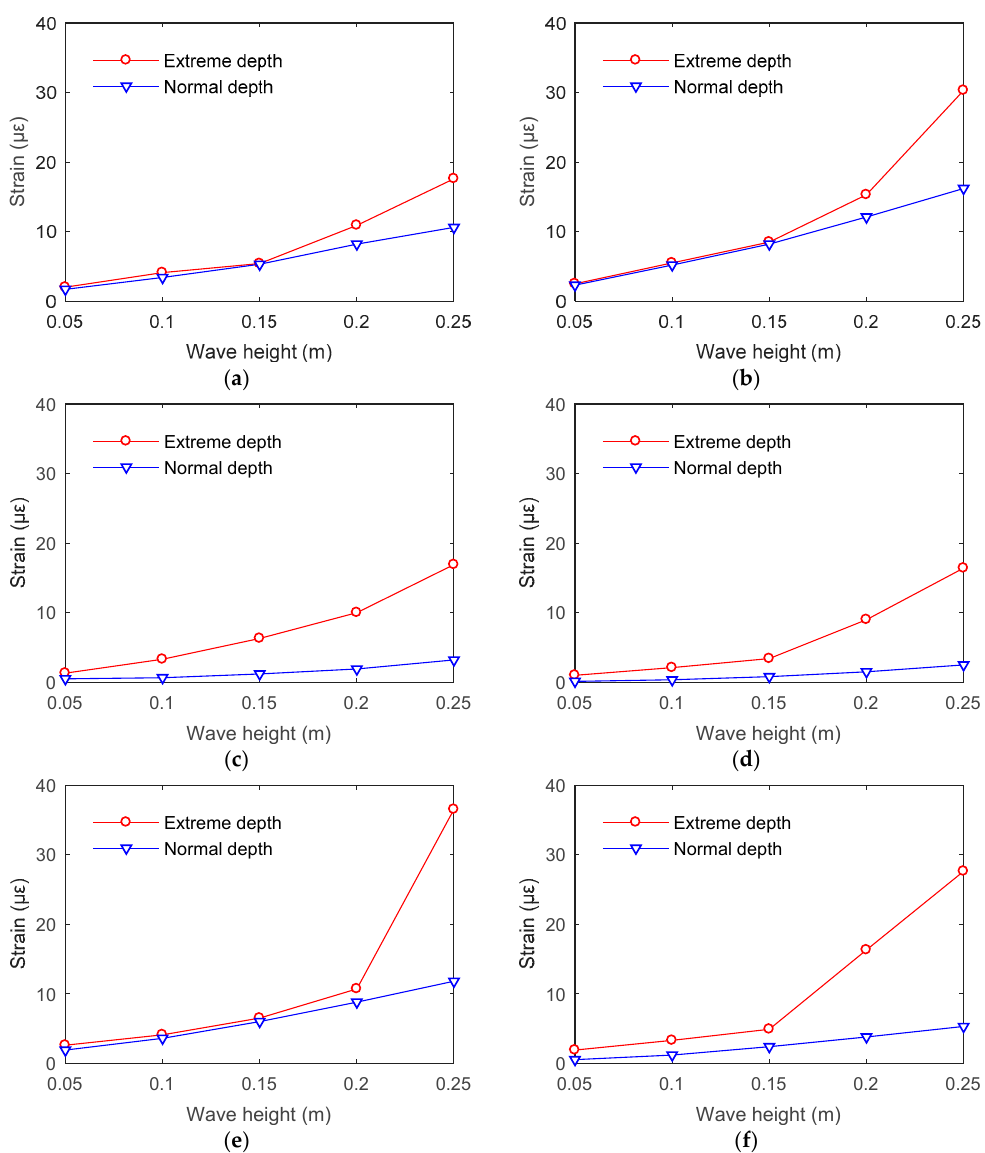
Figure 15. Structural strain responses at various measurement positions of the electrical platform with di ff erent water depths in waves for wave period of 1.6 s. ( a ) S1; ( b ) S2; ( c ) S3; ( d ) S4; ( e ) S5; ( f )